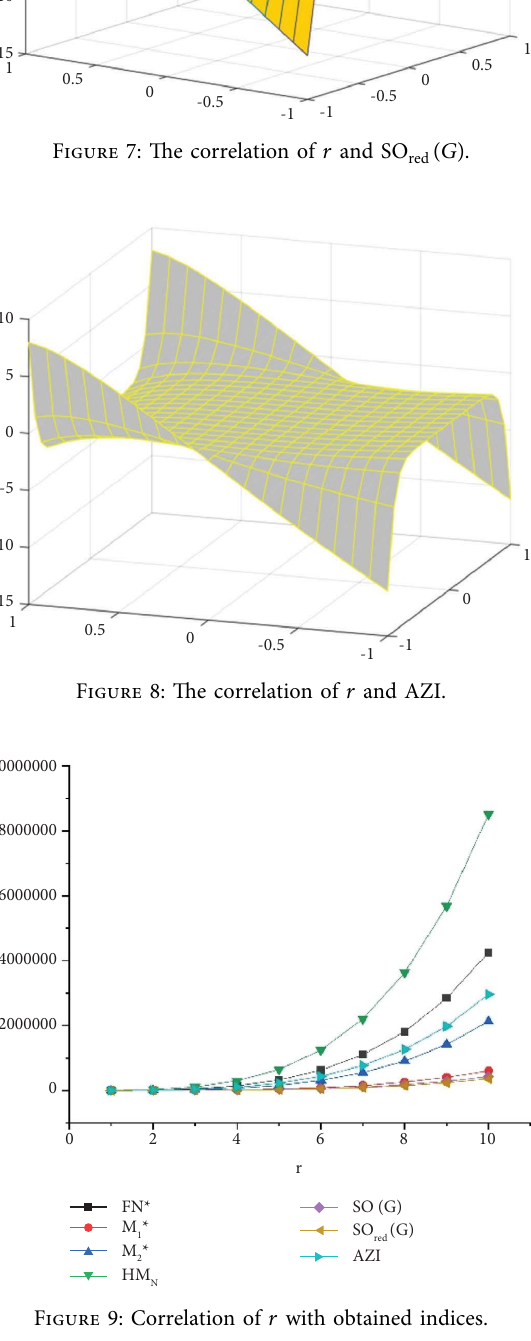
Figure 9: Correlation of r with obtained